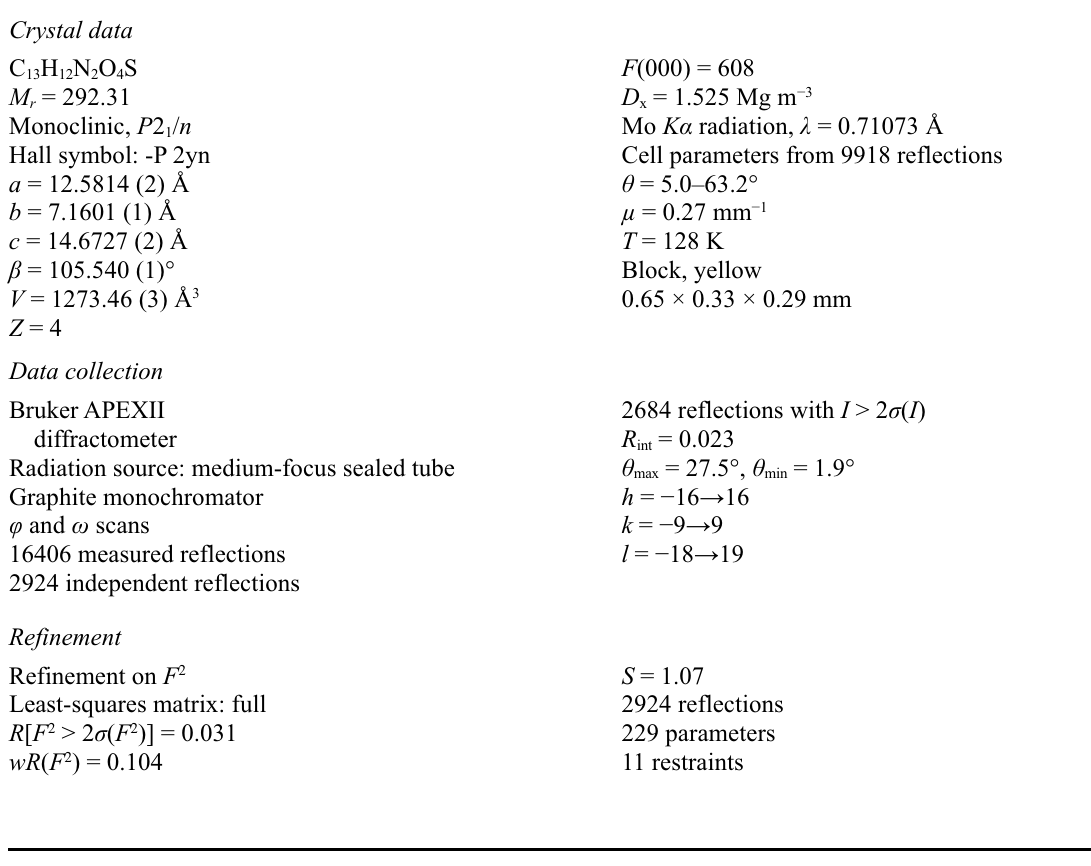
A view of the ribbon structure of the title compound. Dashed lines indicate hydrogen bonds. N ′